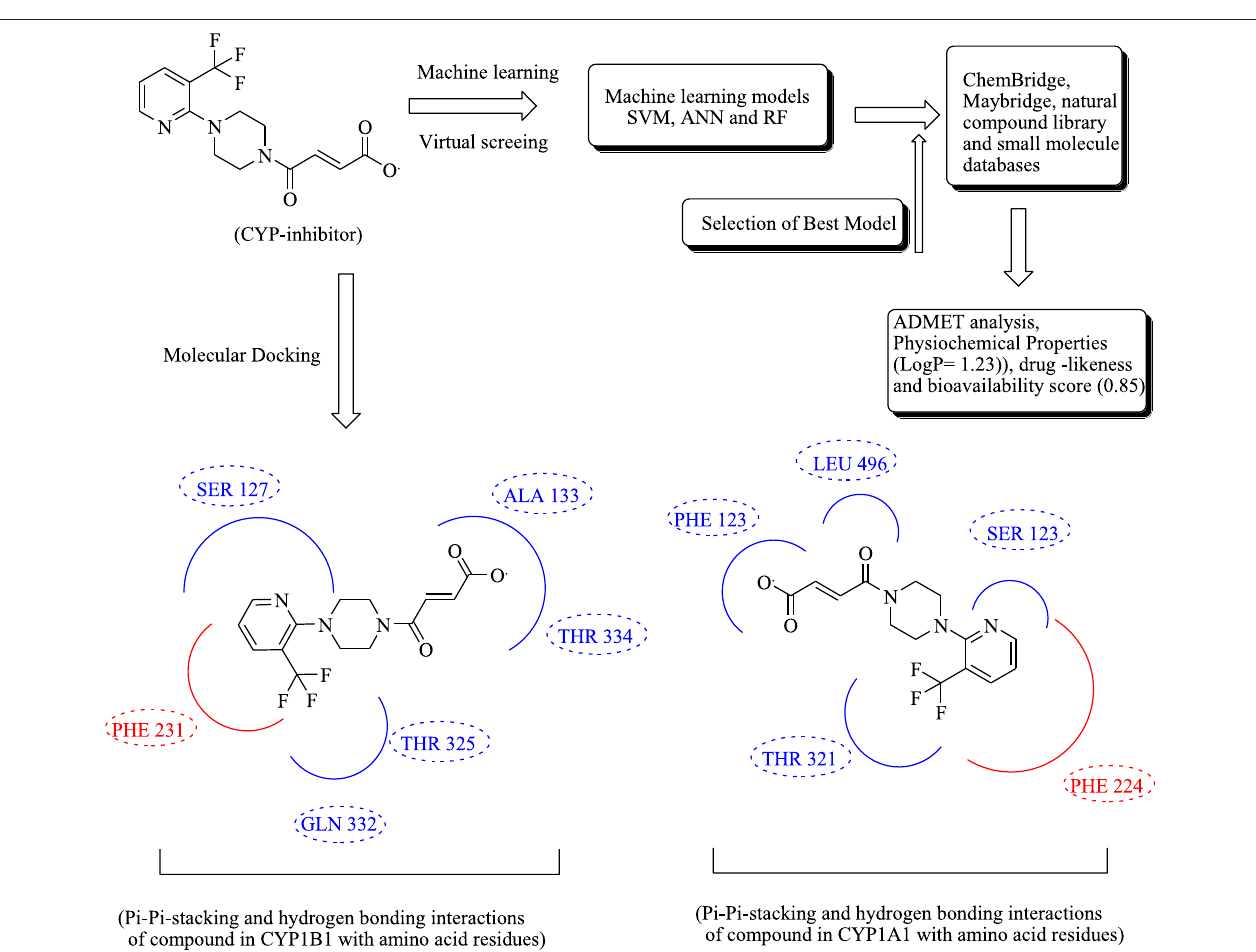
FIGURE 13 | Schematic representation of machine learning and molecular docking of CYP inhibitors.